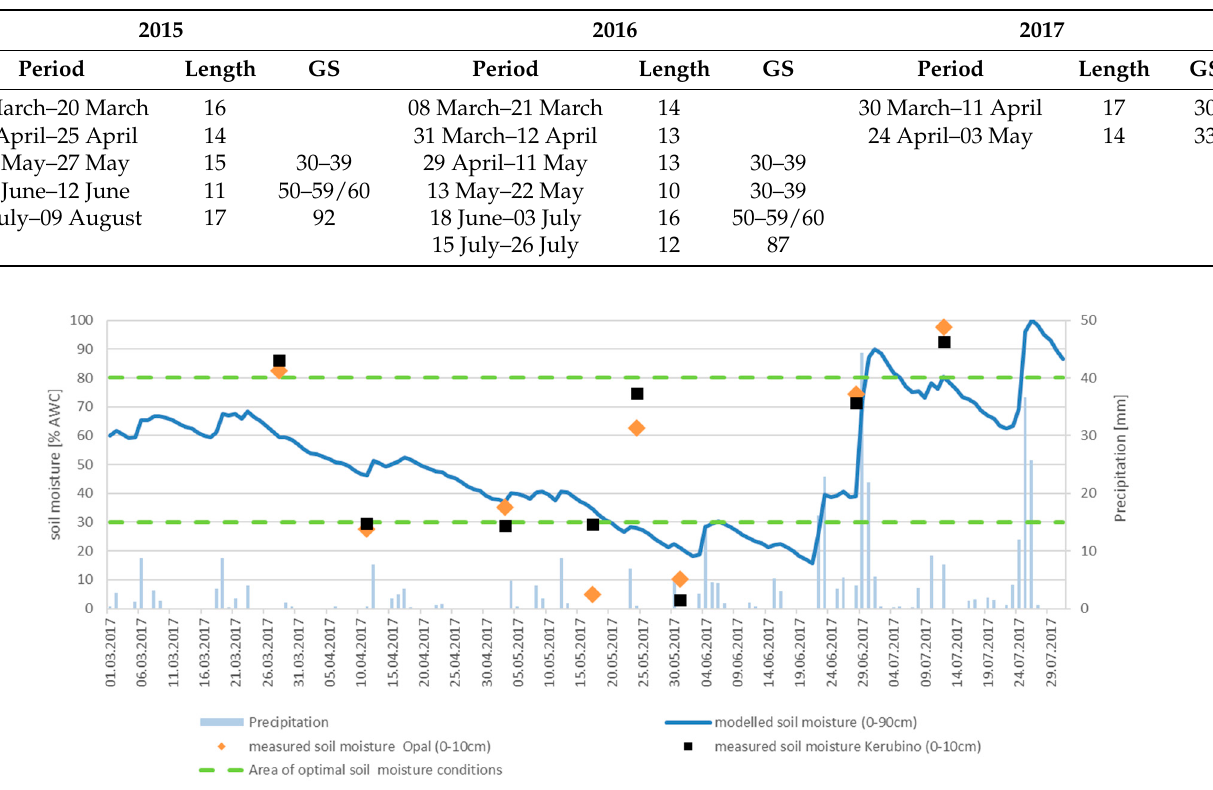
Figure 4. Modeled and measured soil moisture [% AWC] of t irrigated winter wheat plots Opal and Kerubino and precip ‐ itation [mm] in the period March to July 2017 . In 2017, growth differences were identified between the two varieties Kerubino and Edgar. The plant height of both winter wheat varieties was on average ~4 cm (Edgar) and ~3 cm (Kerubino) higher (Figure 5). At the end of the vegetation phase, this difference became clearer: on 12 July there was a difference of 12 cm for Kerubino and 7 cm for Edgar.